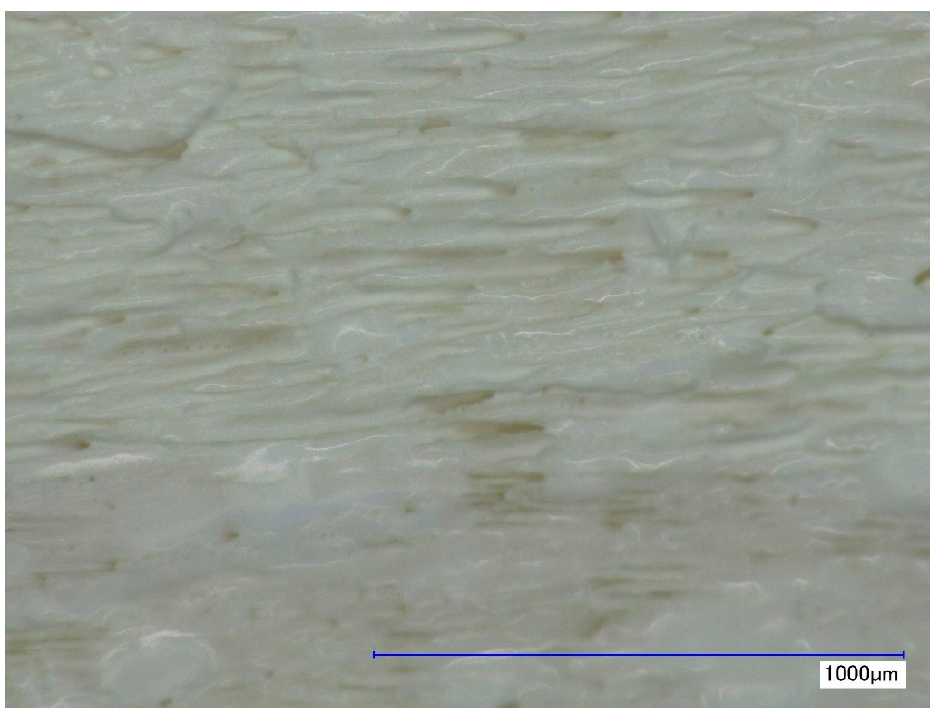
Figure 1. Light microscopic image of the PS sphere coated pine wood sample.